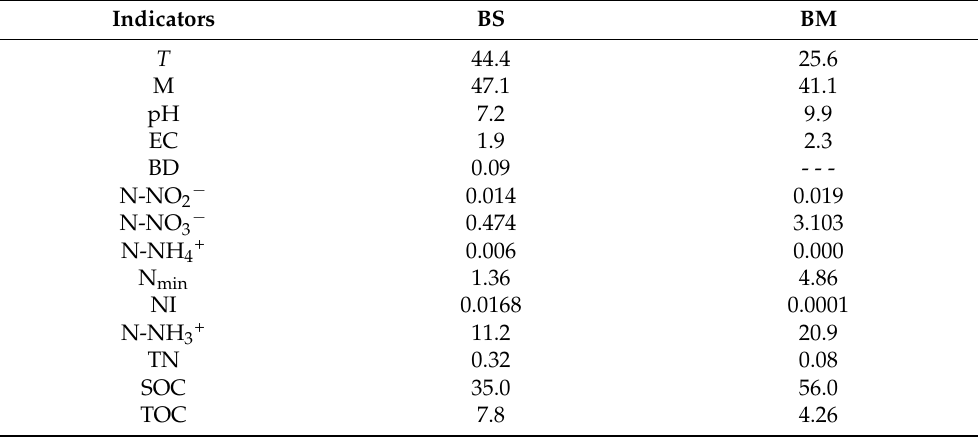
Table 2. Initial values of physicochemical indicators for BS and BM. Indicators